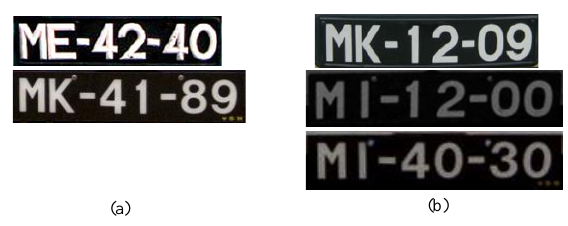
Figure 2: Example of variations in character spacing Multiple license plates - Macao is geographically bordering to China, and China Government allows vehicles from Macao to travel in China with registered China license plates shown. Thus, some vehicles have two license plates shown in their front end and rear end.